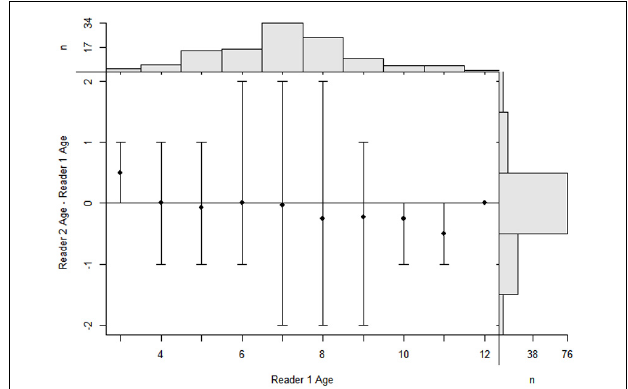
FIGURE 5 | Age-bias plot of reader 1 estimates versus reader 2 estimates. Mean (dots) and range (intervals) of differences in vertebrae age estimates between two readers at the estimates for the first reader for P. kamoharai in the Tropical Eastern Atlantic Ocean. The agreement line, which is the horizontal line suggests, a difference in the two age estimates from readers. Marginal histograms are for age estimates of the first reader (top) and differences in age estimates between readers (right). The bar at a difference of zero represents the amount of perfect agreement between the sets of age estimates ( n = 76).